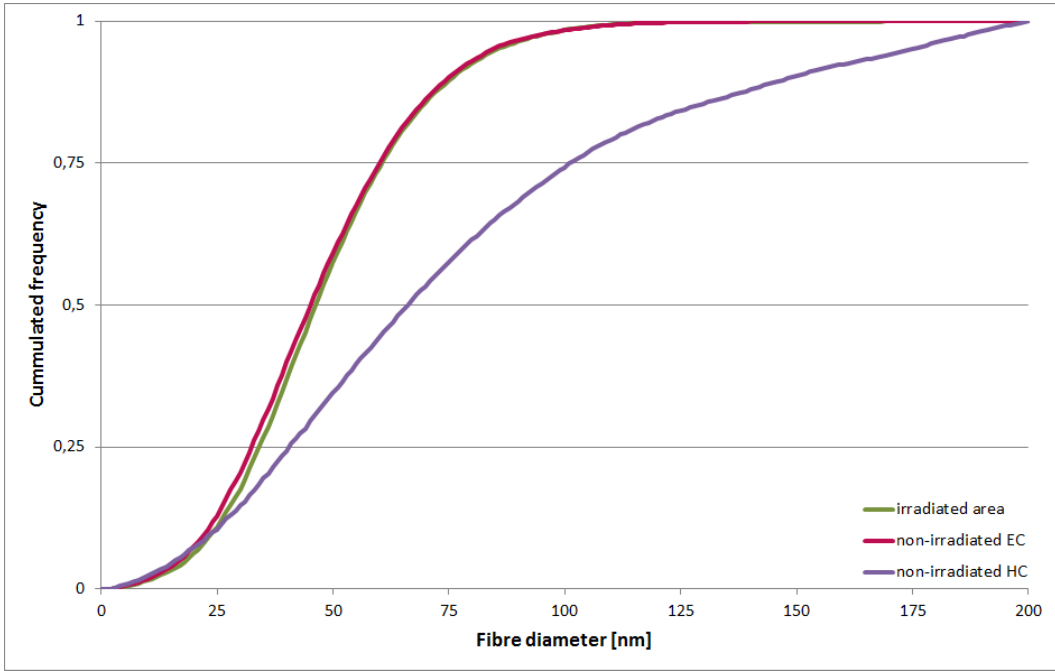
Figure 6. Cumulative histogram of fiber diameter of irradiated areas (green), non-irradiated EC (red), and HC (purple): Irradiated area shows a distribution of fiber diameters very similar to non-irradiated EC. The HC curve clearly deviates; it shows a higher proportion of fibers with a larger diameter. Each curve contains pooled data and was normalized to the volume. N = 3 images.